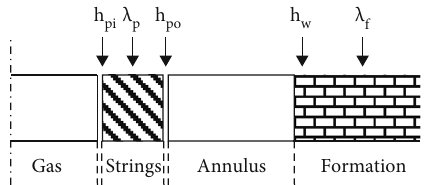
Figure 2: Heat transfer path between wellbore and